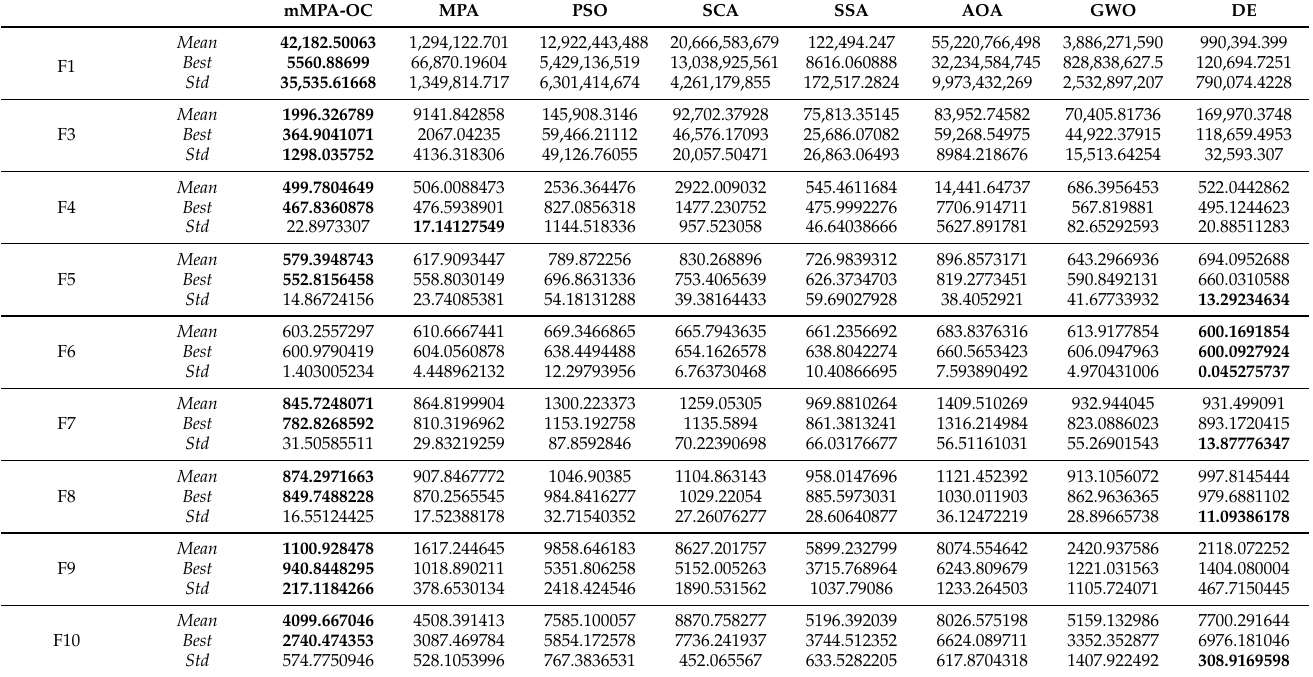
Table 10. Comparison of experimental results on single-peak and multi-peak functions of CEC-2017 (30 dimensions).